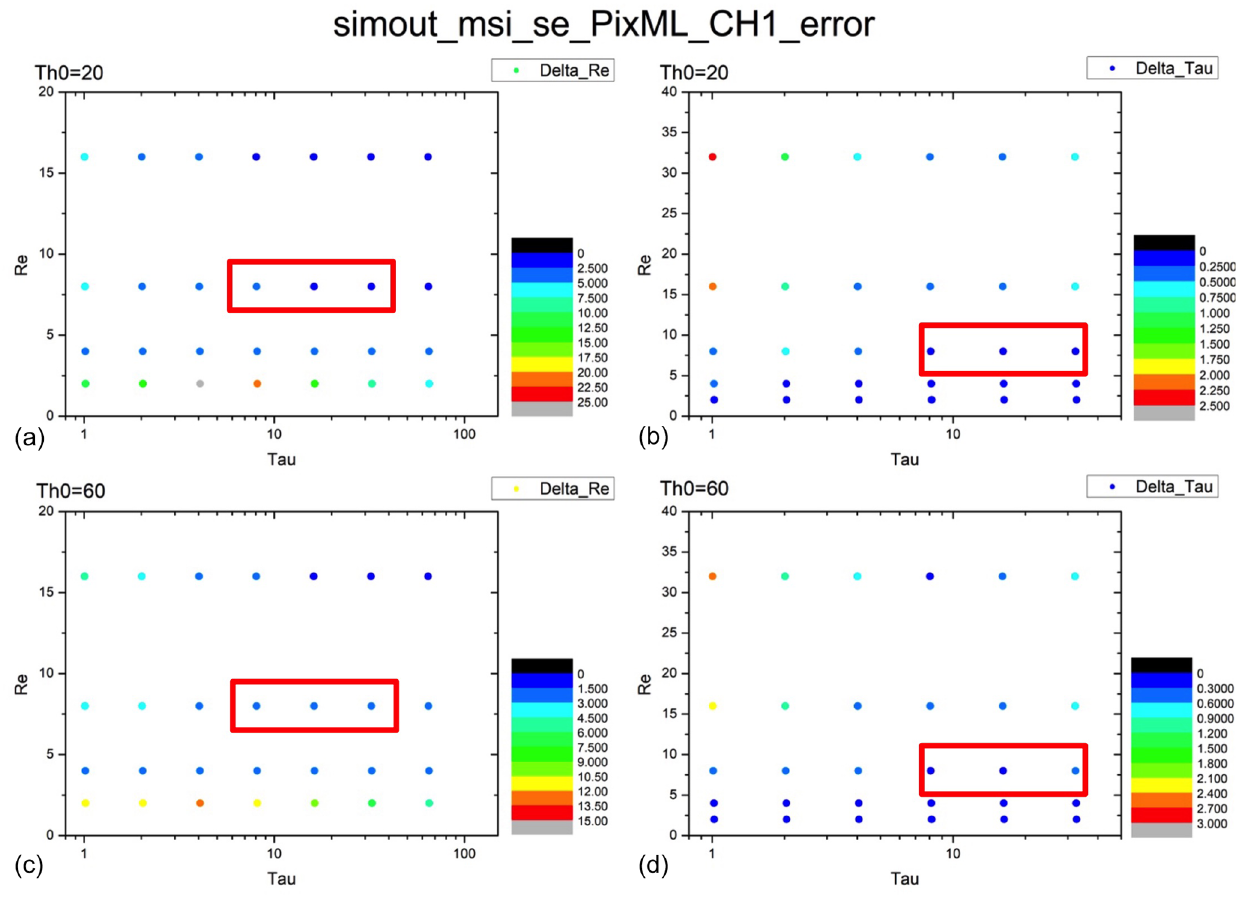
Figure 8. Error distributions of COT and CDR from the Nakajima–King diagram for shallow warm clouds at pix_BND1_max. (a) Distri- bution of (cid:49)r e for a solar zenith angle of 20 ◦ . (b) Distribution of (cid:49)τ for a solar zenith angle of 20 ◦ . (c) Distribution of (cid:49)r e for a solar zenith angle of 60 ◦ . (d) Distribution of (cid:49)τ for a solar zenith angle of 60 ◦ . The red frames show the presence of typical shallow warm cloud. COT = 8 or 32, CDR =